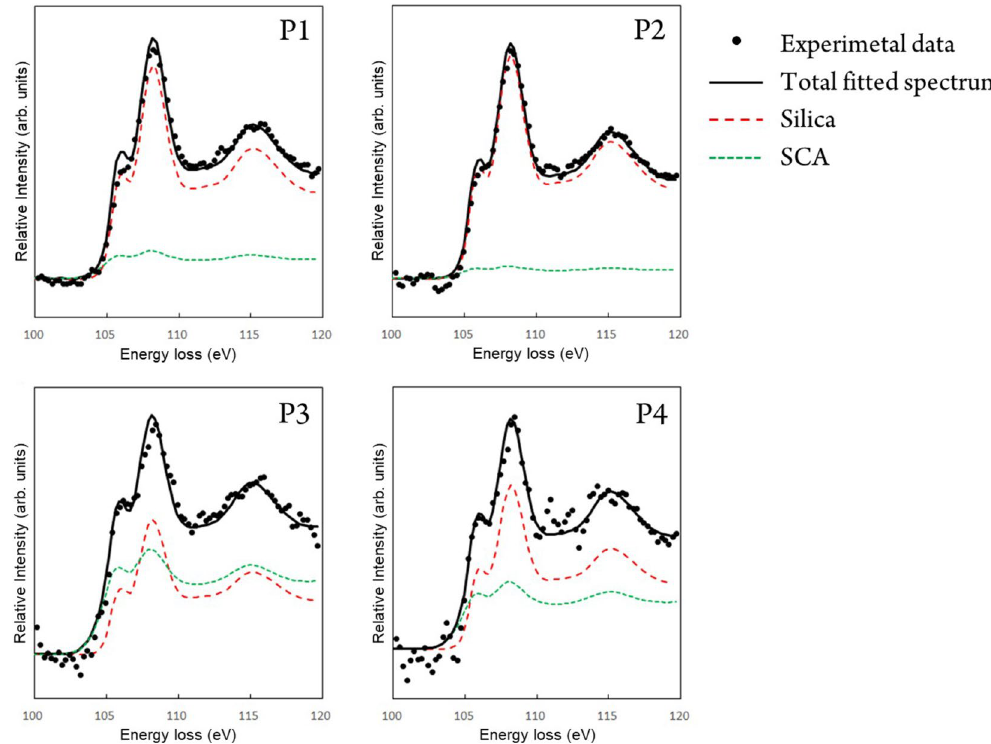
Figure 4. Fitting of the Si-L 2,3 EELS spectra of the SBR composite containing 17 vol % SCA. The dots and solid lines show the experimental and total fitted spectra, respectively. The red dashed and greed dotted lines are the contributions of the reference spectra of silica and SCA to MLLS fitting,